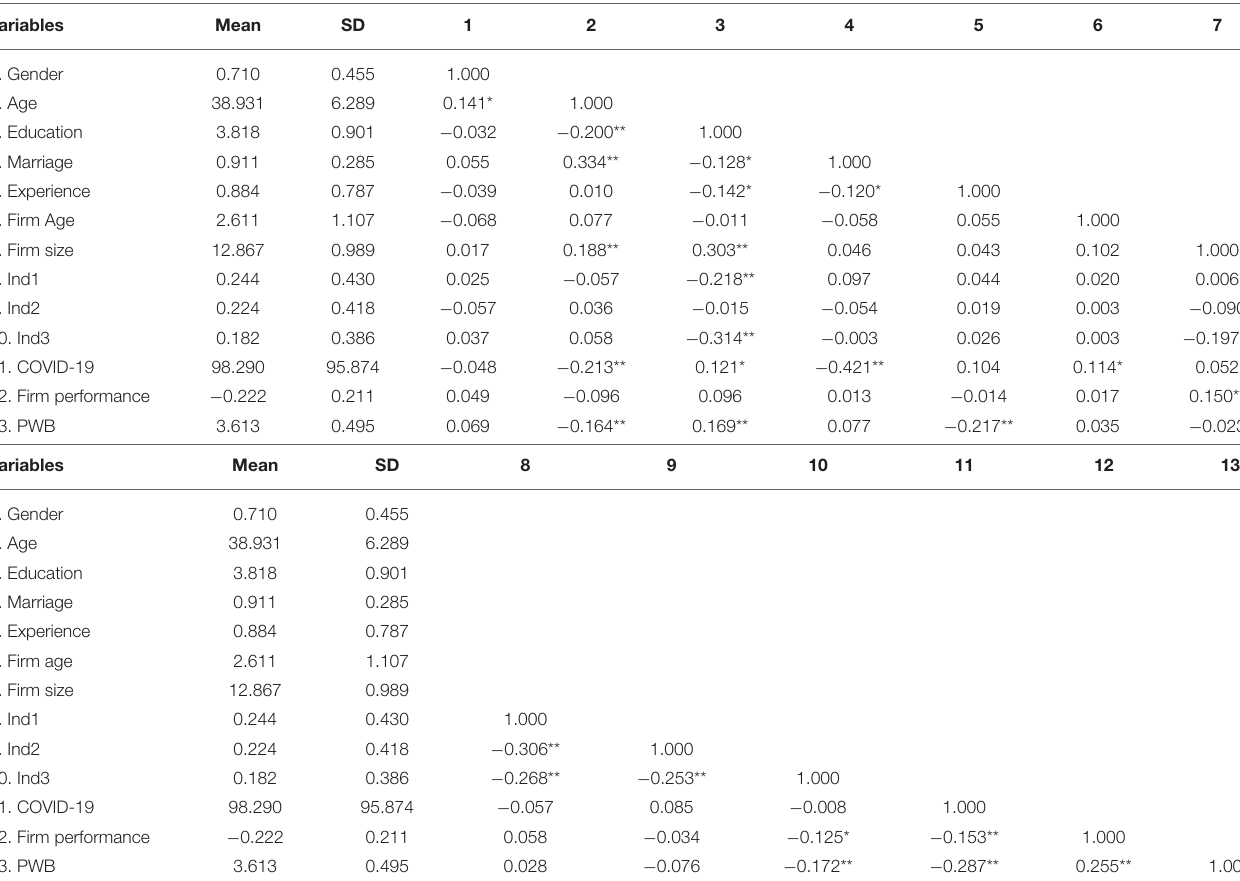
TABLE 2 | Mean, standard deviation, and correlation of study variable.